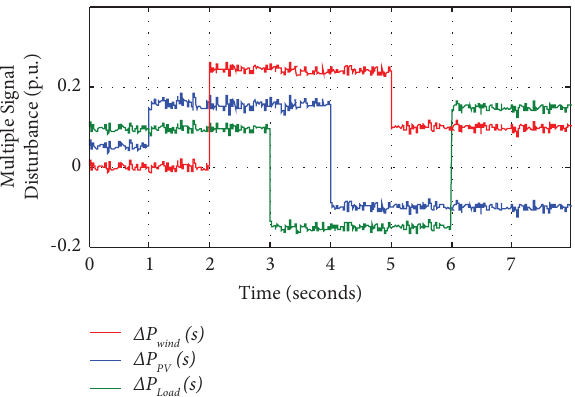
Figure 15: Stochastic values for the inertial constant H and the damping coefcient D in scenario III.